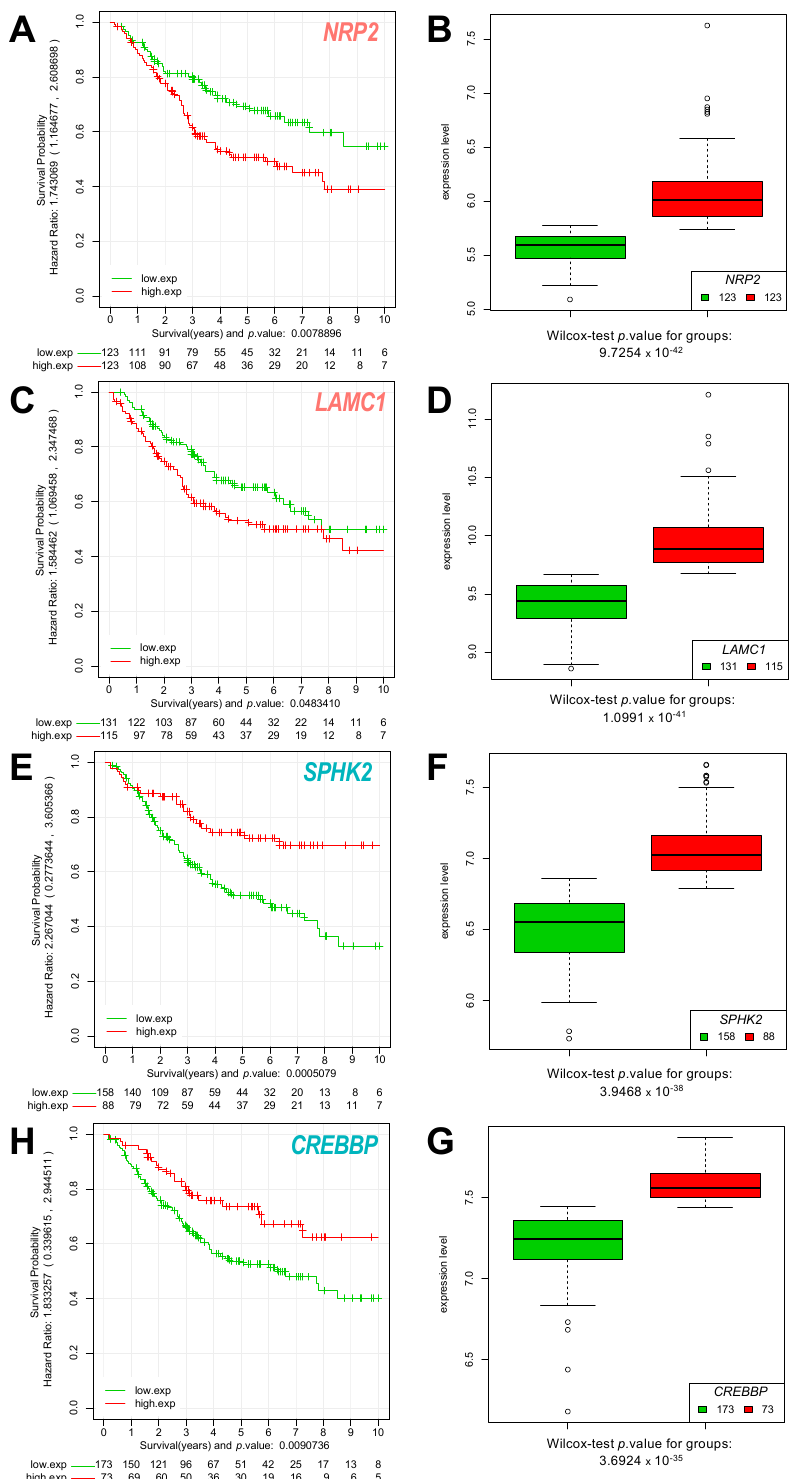
Figure 6. Kaplan–Meier survival analysis of individual genes identified by risk prediction of CRC tumor samples of CMS4 subtype (246 samples). The genes presented are NRP2: ( A ) Kaplan–Meier (KM) curve corresponding to the samples divided by ( B ) the expression level of the gene (high expression red, low expression green). Gene LAMC1: ( C ) KM curve of the samples divided by ( D ) the expression level. Gene SPHK2: ( E ) KM curve of the samples divided by ( F ) the expression level. Gene CREBBP: ( H ) KM curve of the samples divided by ( G ) the expression